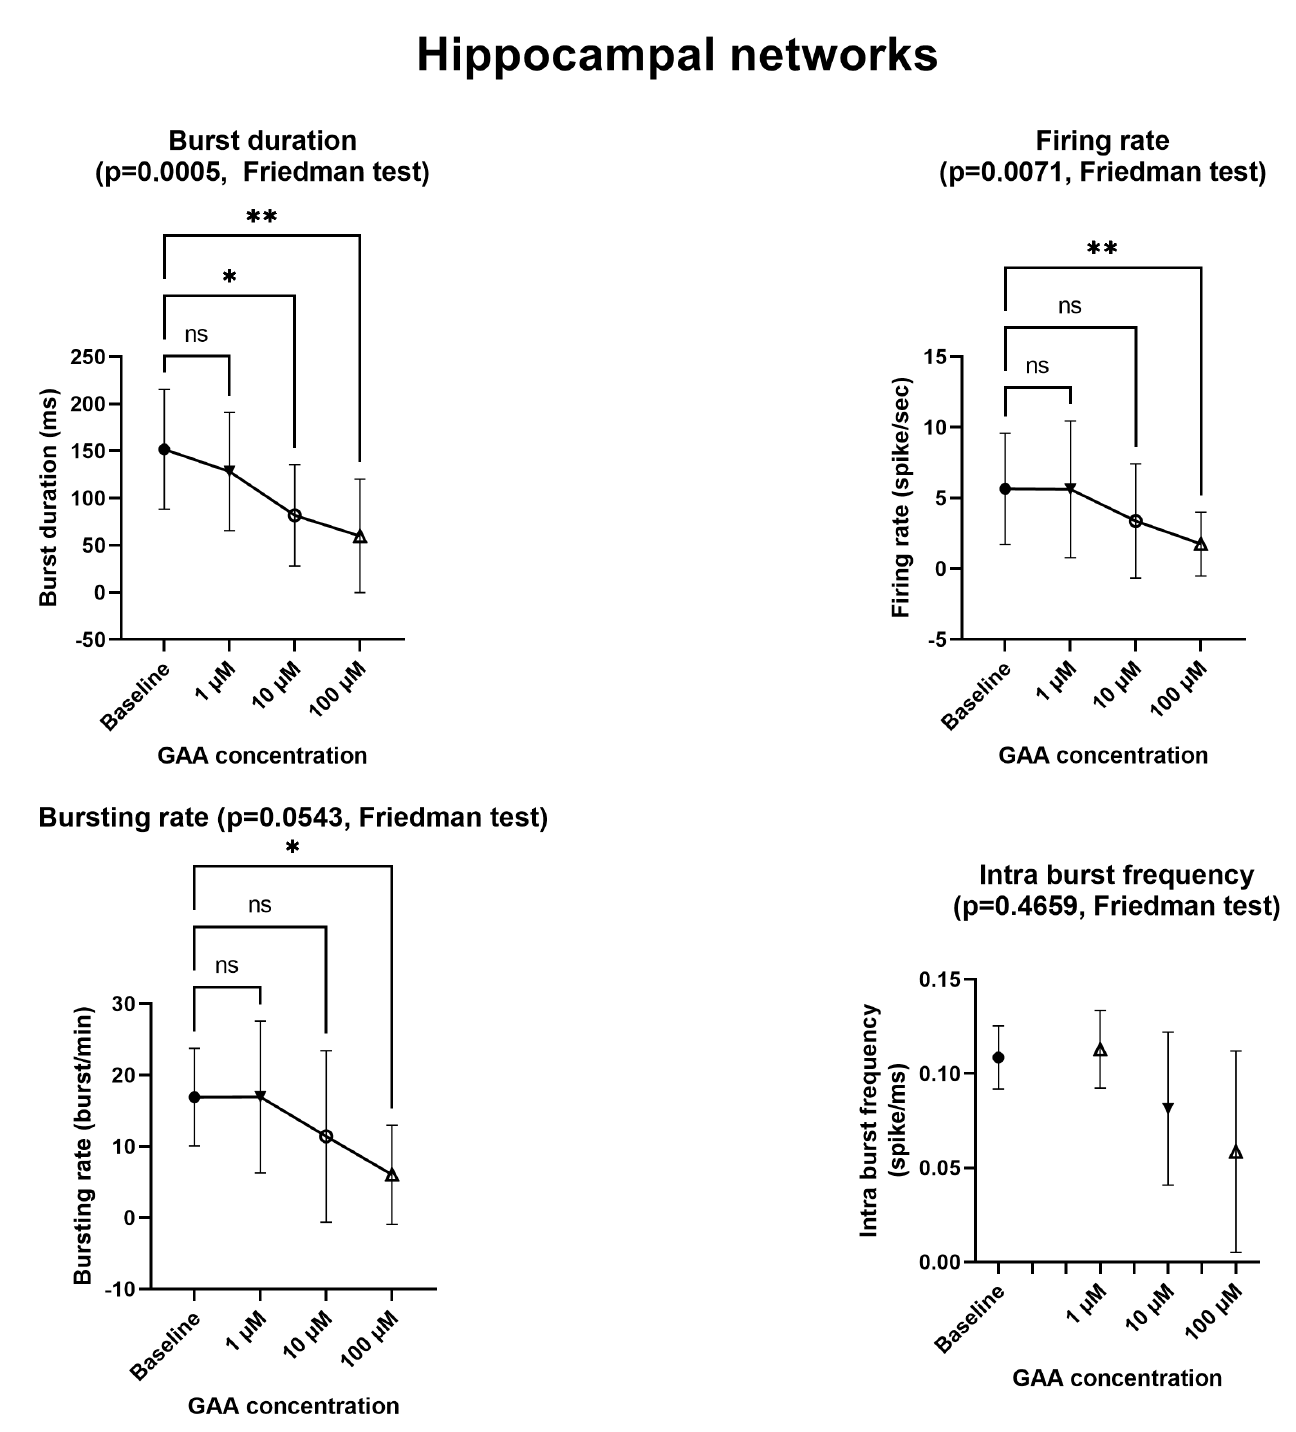
Figure 3. Effects of Guanidinoacetic Acid (GAA) on the spiking and bursting parameters in hippocampal networks. All parameters refer to spontaneous—not stimulus-evoked—activity. Symbols and bars represent mean and standard deviation. Asterisks mark statistically significant differences from baseline (number of asterisks represent number of decimal zeroes before non-zero number, e.g., ** = p < 0.005). ns—not significant. See text for additional explanations.